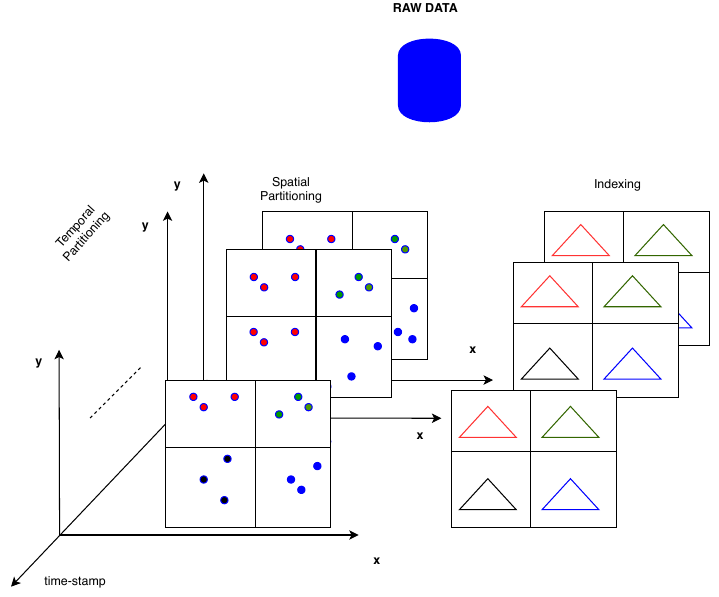
Figure 2. An Overview of Spatio-Temporal Data Partitioning and